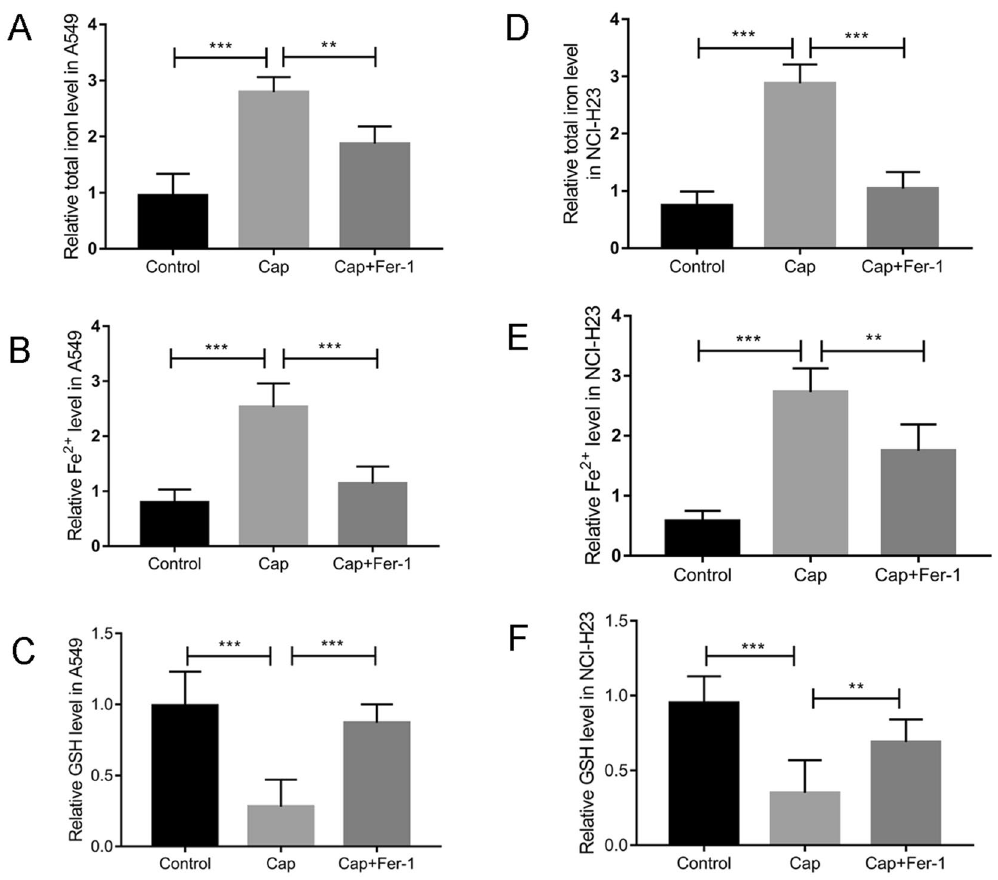
Figure 2. The changes of total iron levels, Fe 2+ levels, and GSH levels in A549 and NCI-H23 cells. ( A and D ) The changes of total iron levels in A549 and NCI-H23 cells. ( B and E ) The changes of Fe 2+ levels in A549 and NCI-H23 cells. ( C and F ) The changes of GSH levels in A549 and NCI-H23 cells. (** P < 0.01, *** P <